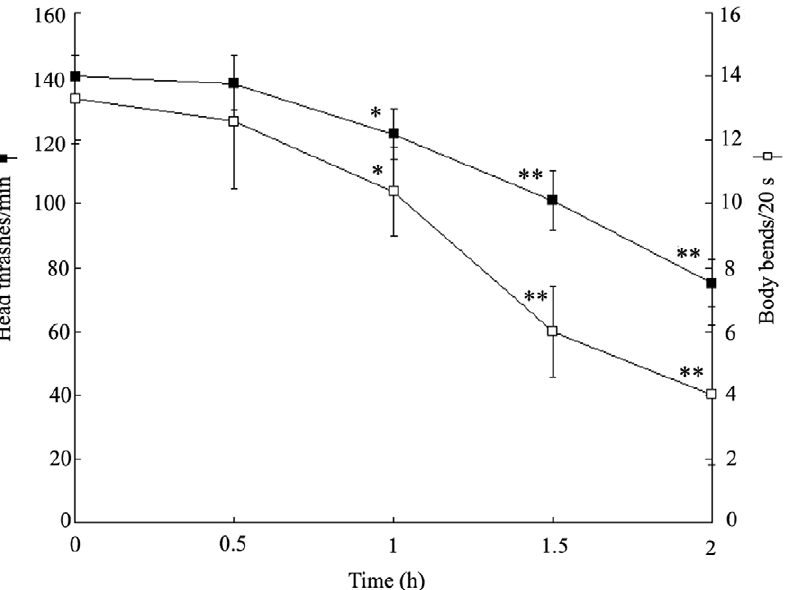
Figure 1. Neurobehavioral toxicity induced by heat-shock in wild-type N2 nematodes. L4-stage larvae animals were heat stressed for 0.5, 1, 1.5, 2 h at 36 u C. Bars represent means 6 S.D. * p , 0.05 vs 0 h; ** p , 0.01 vs 0 h.